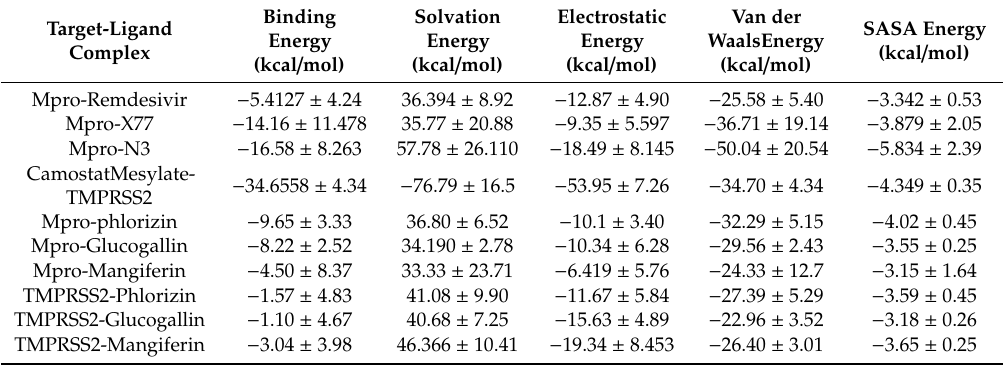
Table 4. Predicted MM-PBSA analysis for calculation of thermodynamics